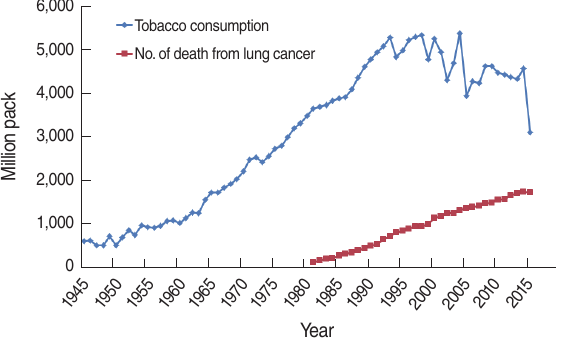
Figure 3. Tobacco consumption and lung cancer deaths in